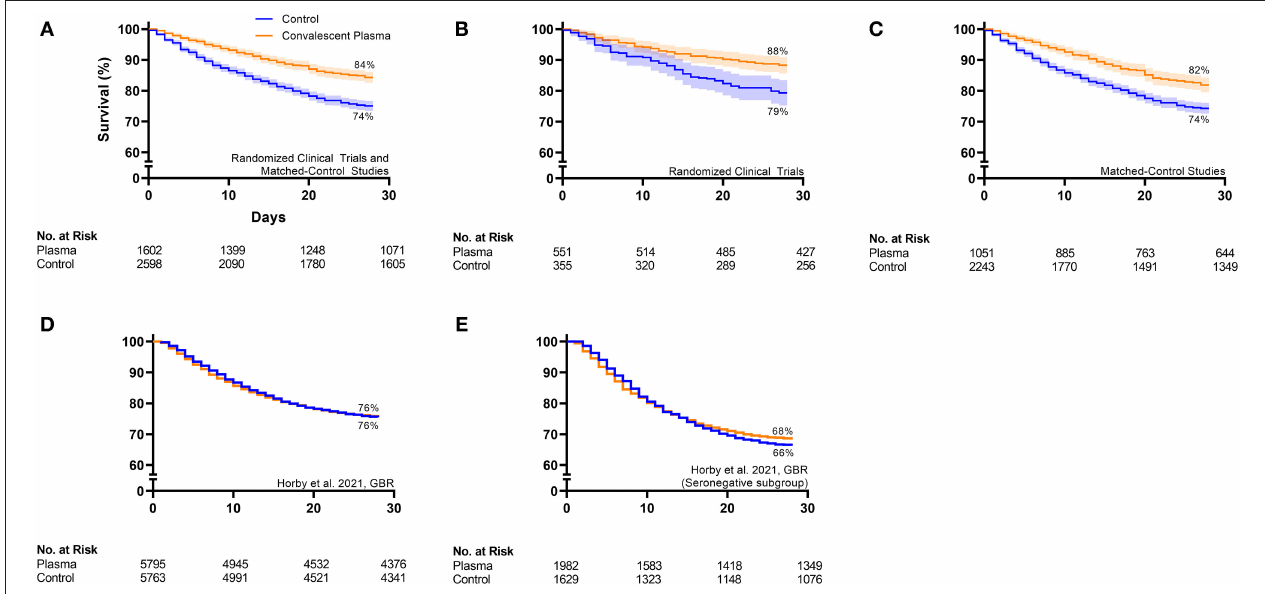
FIGURE 2 | Aggregate Kaplan–Meier survival plots from all available controlled studies investigating convalescent plasma therapy for COVID-19. (A) Pools all controlled studies [ n = 6 randomized clinical trials ( 11, 27, 41, 43, 47, 71, 74) and n = 9 matched-control studies (50, 52, 59–62, 64, 69, 70)] with available Kaplan–Meier survival data except for the large randomized clinical trial, the RECOVERY Trial. (B) Pools randomized clinical trials ( n = 6) with available data except for the RECOVERY Trial. (C) Pools matched-control studies ( n = 9) with available data. (D) Shows the RECOVERY Trial data from the overall cohort, and (E) shows the RECOVERY Trial data from the subgroup of patients that were seronegative at the time of plasma transfusion. Available 28-day Kaplan–Meier survival data from worldwide controlled studies was extracted, pooled, and replotted. For each panel, the orange line represents the survival of the cohort transfused with convalescent plasma, and the blue line represents the survival of the cohort that received standard of care or placebo transfusion. Error bands represent 95% confidence intervals. The 28-day survival (%) for the aggregate convalescent plasma cohort and the aggregate control cohort is presented. The table at the bottom of each panel presents the number at risk on the day of enrollment or randomization, day 10, day 20, and day 28 for the aggregate convalescent plasma cohort and the aggregate control cohort. Interpretation: The aggregate survival data from (A) all controlled studies except for the RECOVERY Trial, (B) all randomized clinical trials except for the RECOVERY Trial, and (C) all matched-control studies revealed a consistent pattern whereby convalescent plasma transfusion was associated with greater patient survival compared to non-transfused patients. (D) The overall RECOVERY Trial cohort demonstrated no survival benefit of convalescent plasma. (E) The modest efficacy signal from the RECOVERY Trial subgroup of seronegative patients supports the concept that early plasma transfusion reduces patient